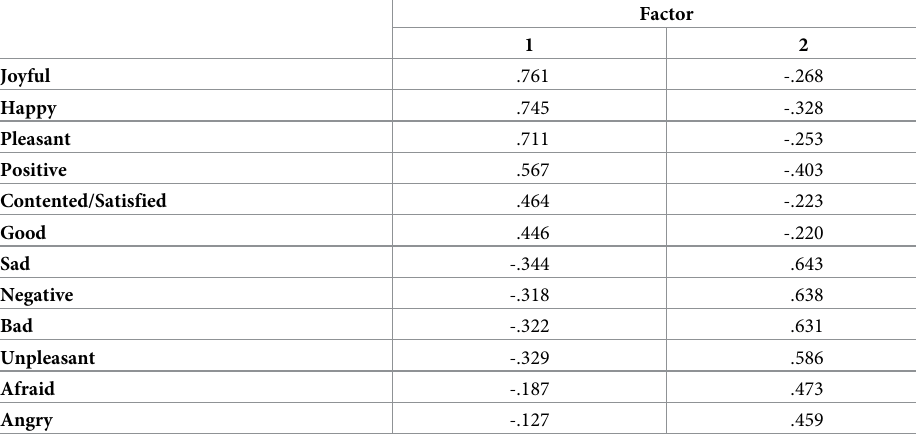
Table 4. Principal axis factoring—Factor loadings.